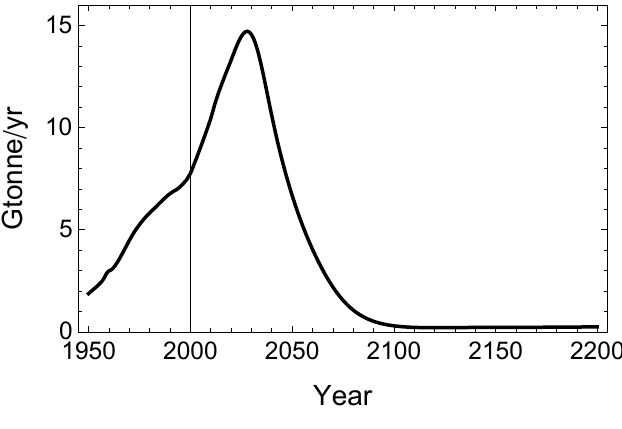
Figure 3. Global carbon emissions (in billions of metric tons per year) with a strong shift to nuclear energy use.